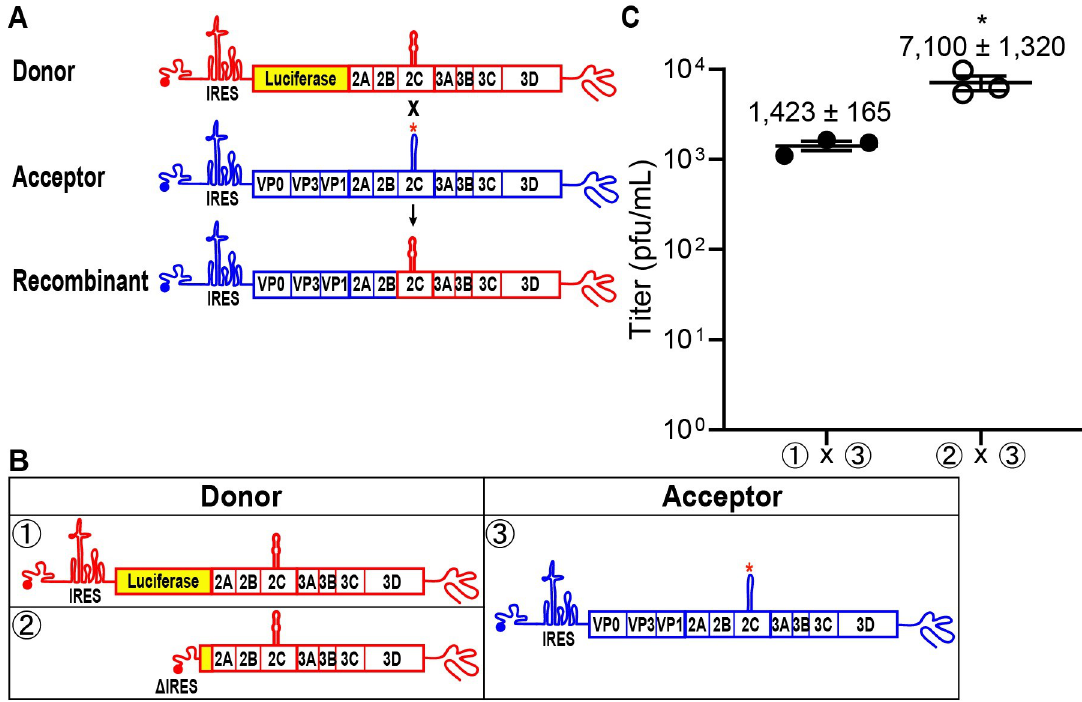
Fig 2. RNA virus recombinants are recovered after deletion of the PV IRES in a donor subgenomic replicon RNA. (A) Schematic of the cell-based assay for PV recombination [13,14,75]. Two RNAs are used in the assay, a replication-competent PV subgenomic RNA (Donor, red) in which capsid-coding sequence is replaced with luciferase coding-sequence and a replication-incompetent full-length PV genomic RNA (Acceptor, blue) with a defective cis -acting replication element (indicated by red � ). Cotransfection of these RNAs in a L929 mouse fibroblast cell line produces infectious virus if recombination occurs resulting in a replication-competent, full-length PV genomic RNA. Infectious virus produced by recombination can be quantified by plaque assay using HeLa cells. (B) Comparison of infectious virus produced between donor RNAs with either an intact IRES ( ① ) or when the entire IRES and majority of luciferase coding sequence (nt 41–2,393, Δ IRES) was deleted ( ② ) [13]. (C) Recombination between the donor with the deleted IRES ( Δ IRES) and acceptor RNA ( ② x ③ ) produces 5-fold more recombinant virus compared to the corresponding control ( ① x ③ ). Results show titer of recombinant virus (pfu/mL ± SEM; n = 3 ). Statistical analyses were performed using unpaired, two-tailed t test ( � indicates p < 0.05). Numerical data provided as Supporting information (S1 Data). IRES, internal ribosome entry site; PV, poliovirus.